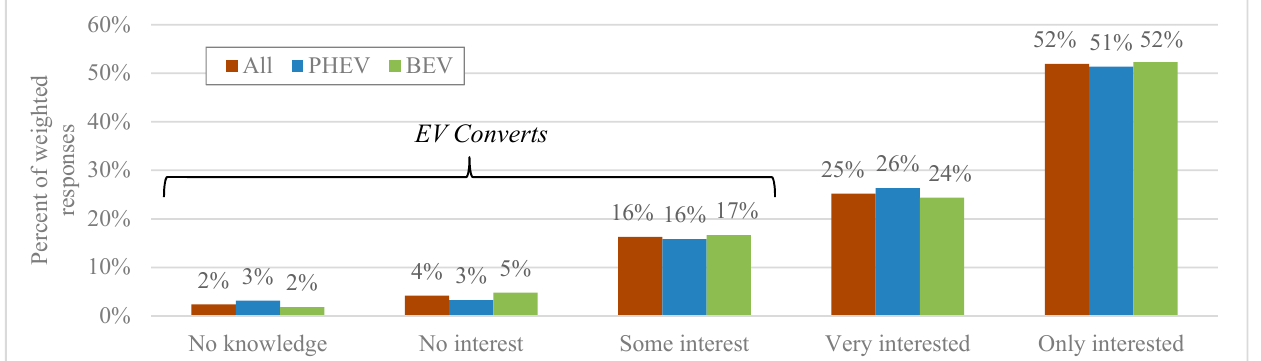
Figure 1. Knowledge of or Interest in a PEV at the Start of the New Car Search (data available: [29]). Predictor ( Explanatory ) Variable Preparation . The predictor variables were